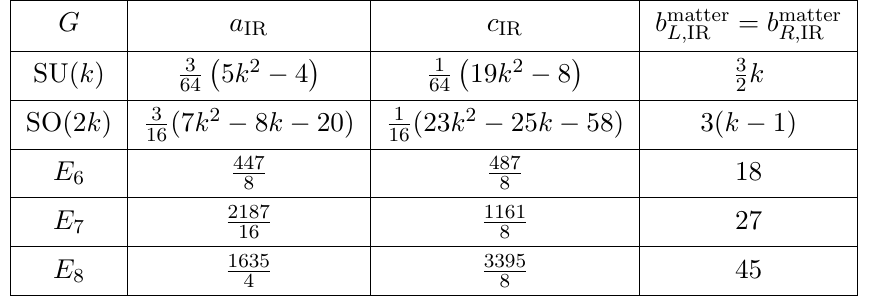
= b matter for N = 1 deformation of N = 2 theories with L; IR R; IR